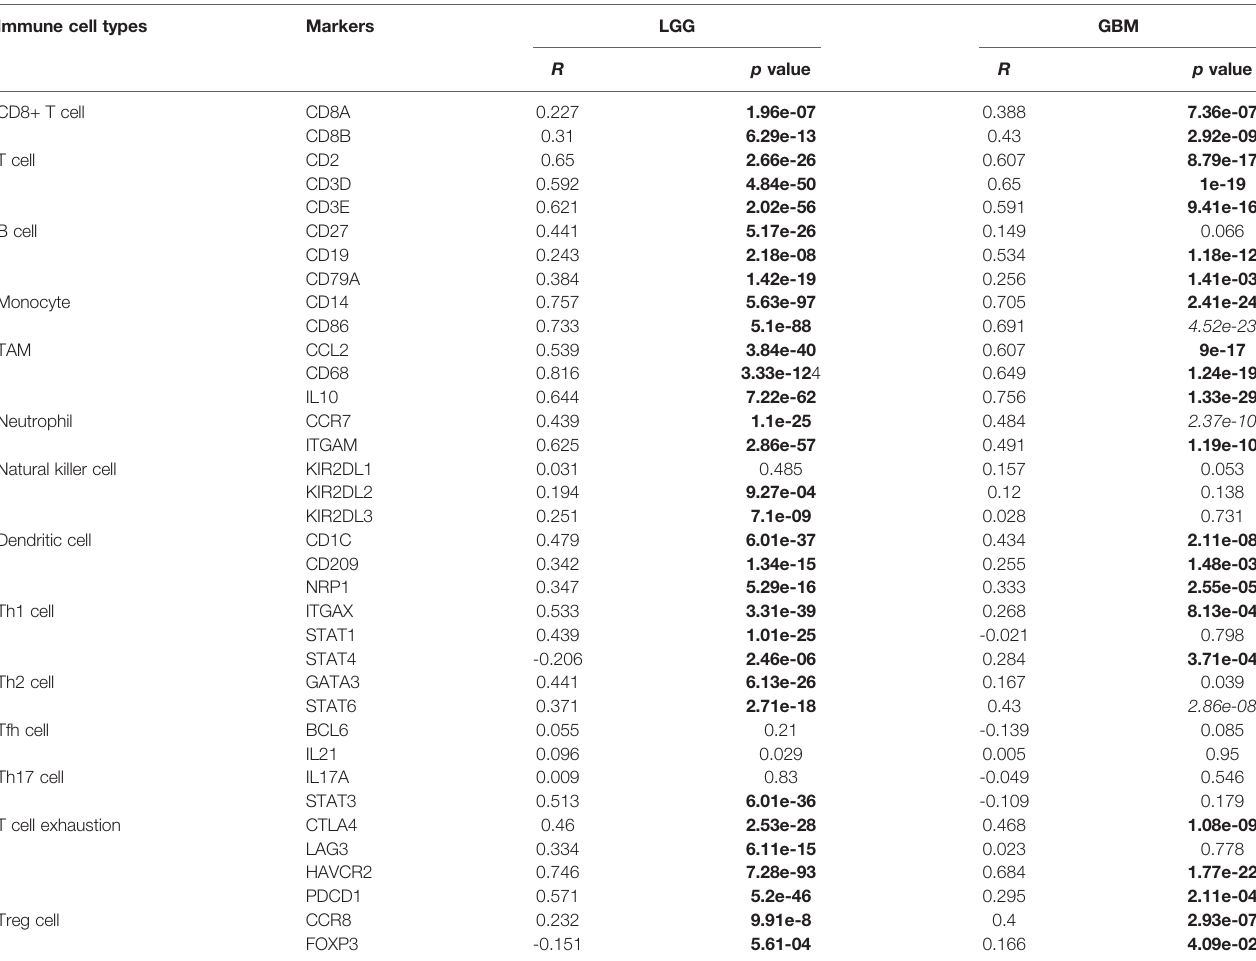
The bold indicates statistical signi fi